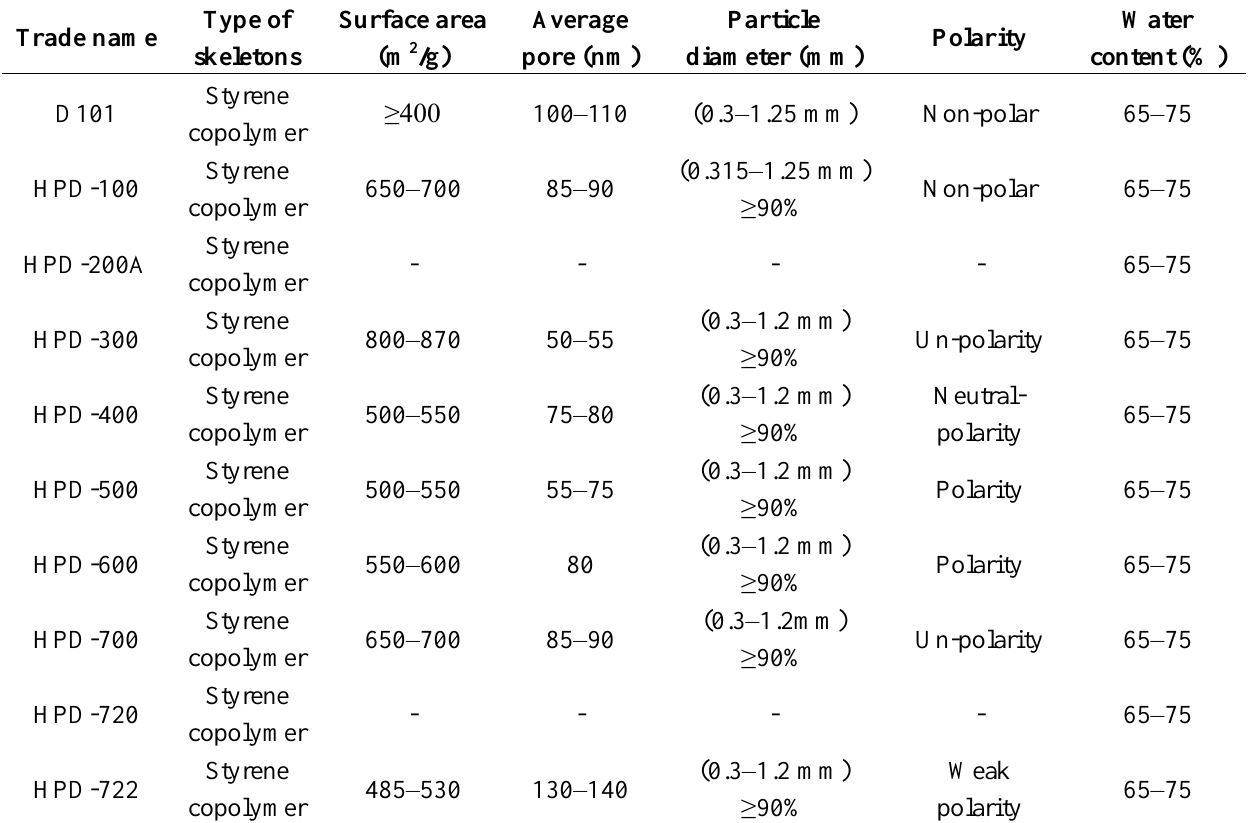
Table 2. Physical and chemical properties of the